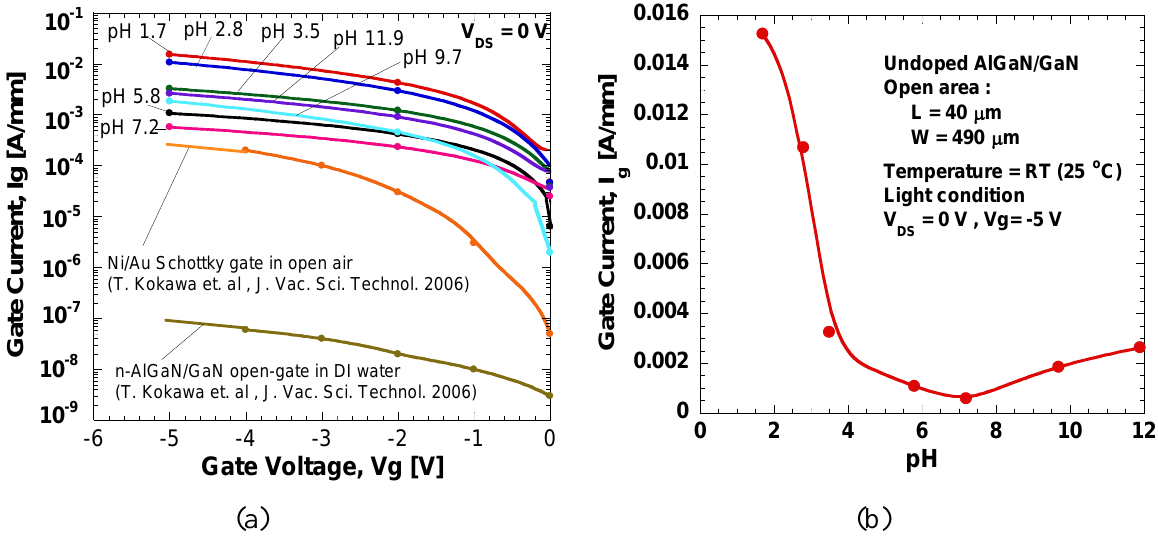
Figure 8. (a) Gate-leakage characteristics of the open gate undoped AlGaN/GaN HEMT at V = 0 V and (b) Changes of gate leakage current at various pH DS